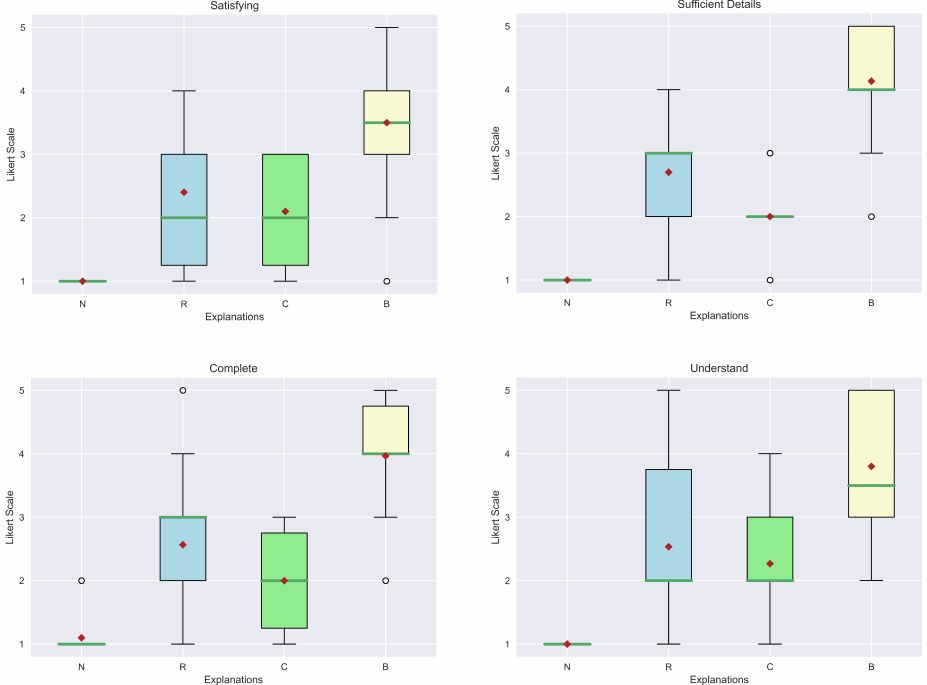
Figure 18. Box plot of the general qualities of the explanations for the “Why” question.